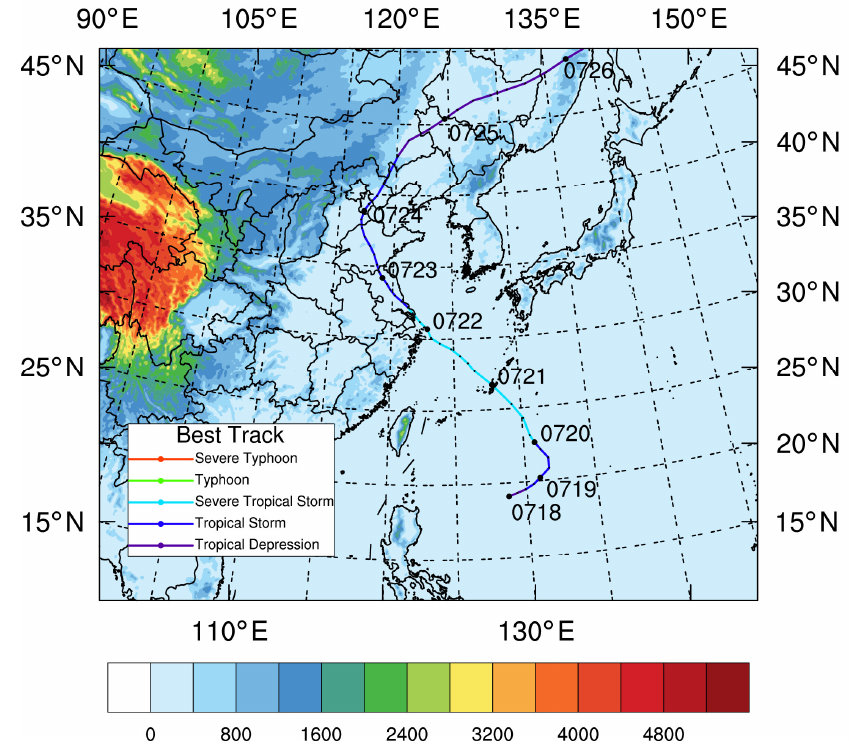
Figure 1. Simulated domain and the track of Typhoon Ampil.